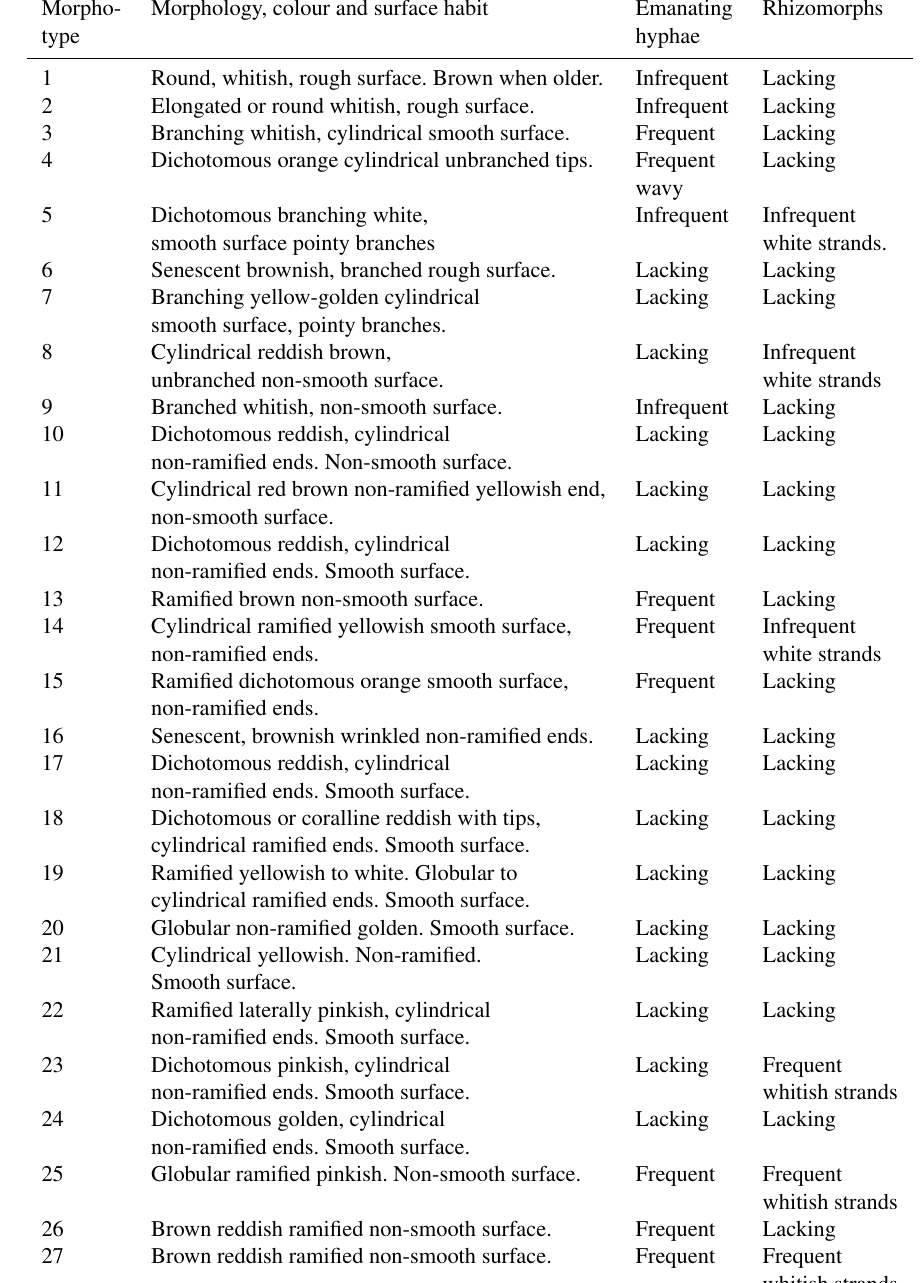
Table 1. Description of the identified morphotypes based on external morphology following the nomenclature of Agerer